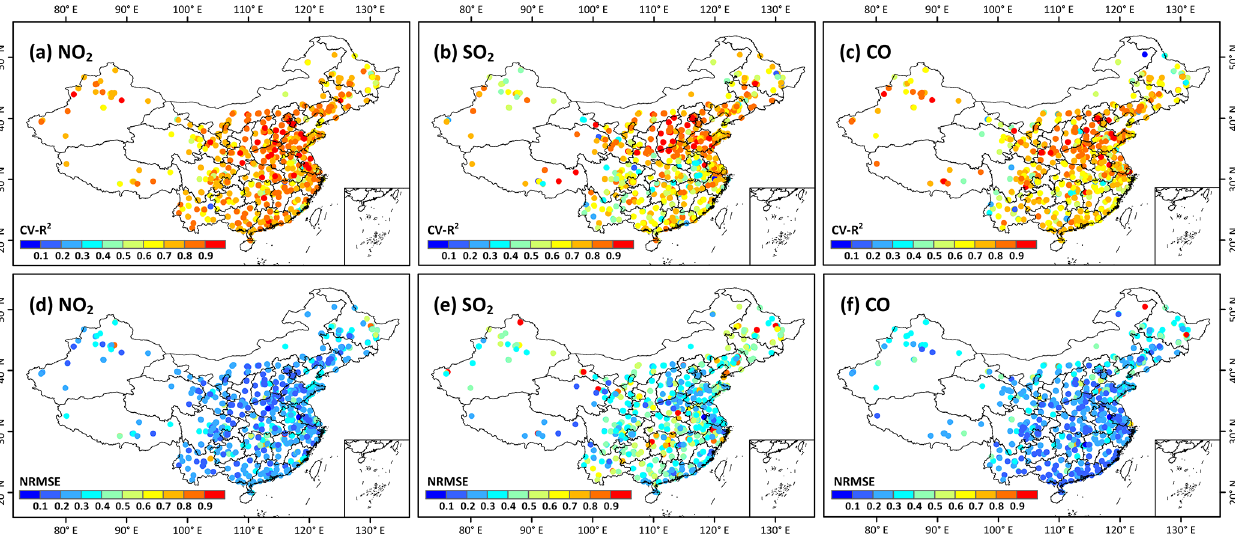
Figure 11. Sample-based spatial validation of daily ground-level NO 2 (µgm − 3 ), SO 2 (µgm − 3 ), and CO (mgm − 3 ) estimates at each individual monitoring station in China from 2013 to 2020: (a–c) accuracy (i.e., CV- R 2 ) and (d–f) uncertainty (i.e., NRMSE).